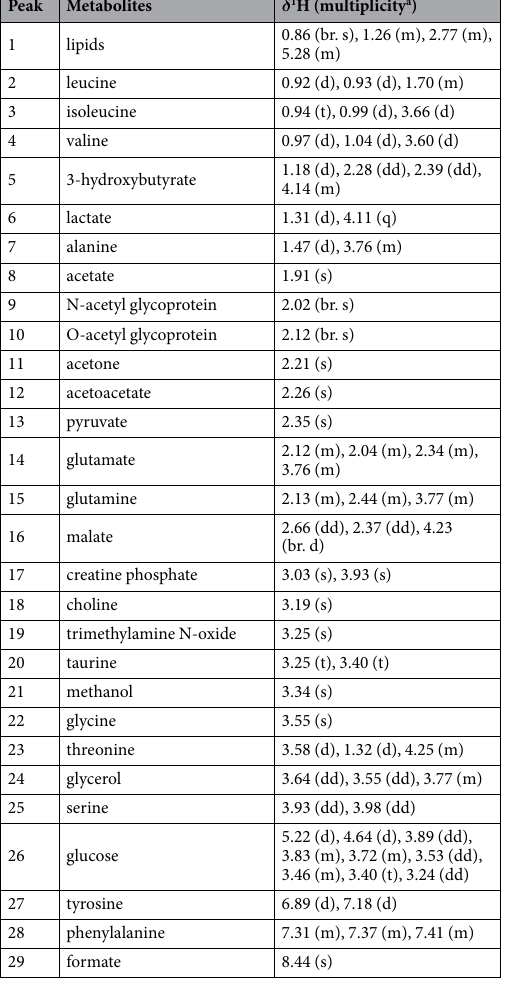
Table 1. 1 H-NMR data for metabolites identified from the rat serum samples. a Multiplicity: singlet (s), doublet (d), triplet (t), doublet of doublets (dd), quintet (q), multiplet